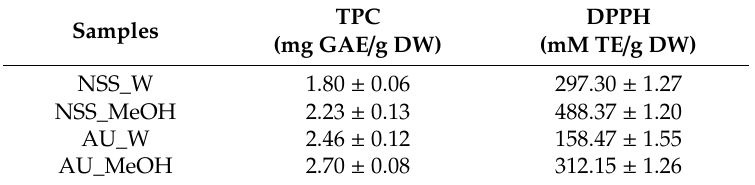
Table 1. Total phenolic content and antioxidant activity of NSS and AU samples.